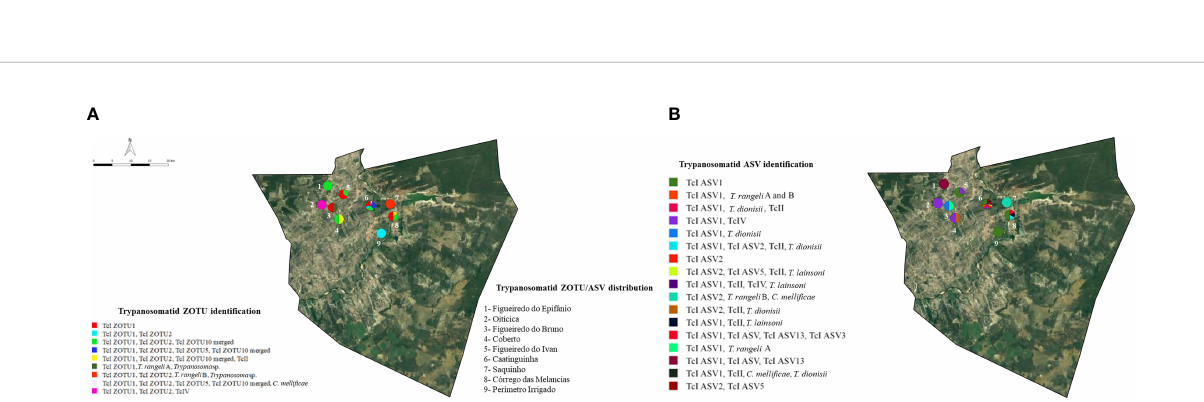
FIGURE 6 | Trypanosomatid distribution map in opossum, rats, and triatomines in Jaguaruana municipality, Ceara ́ state, Brazil. Each color represents a ZOTU (A) and ASV (B) identi fi ed. According to the ZOTU map (A) , the Caatinguinha location exhibited the greatest occurrence of T. cruzi DTU TcI; Figueiredo do Bruno and Saquinho presented greater Trypanosoma spp. diversity. In the ASV map (B) , Caatinguinha and Co ́ rrego das Melancias presented the greatest trypanosomatid diversity. Data sources: Instituto Brasileiro de Geogra fi a e Estat ı ́ stica – IBGE (www.ibge.gov.br); Google Earth (https://www.google.com.br/intl/pt-BR/earth/). The map was constructed using QGIS software